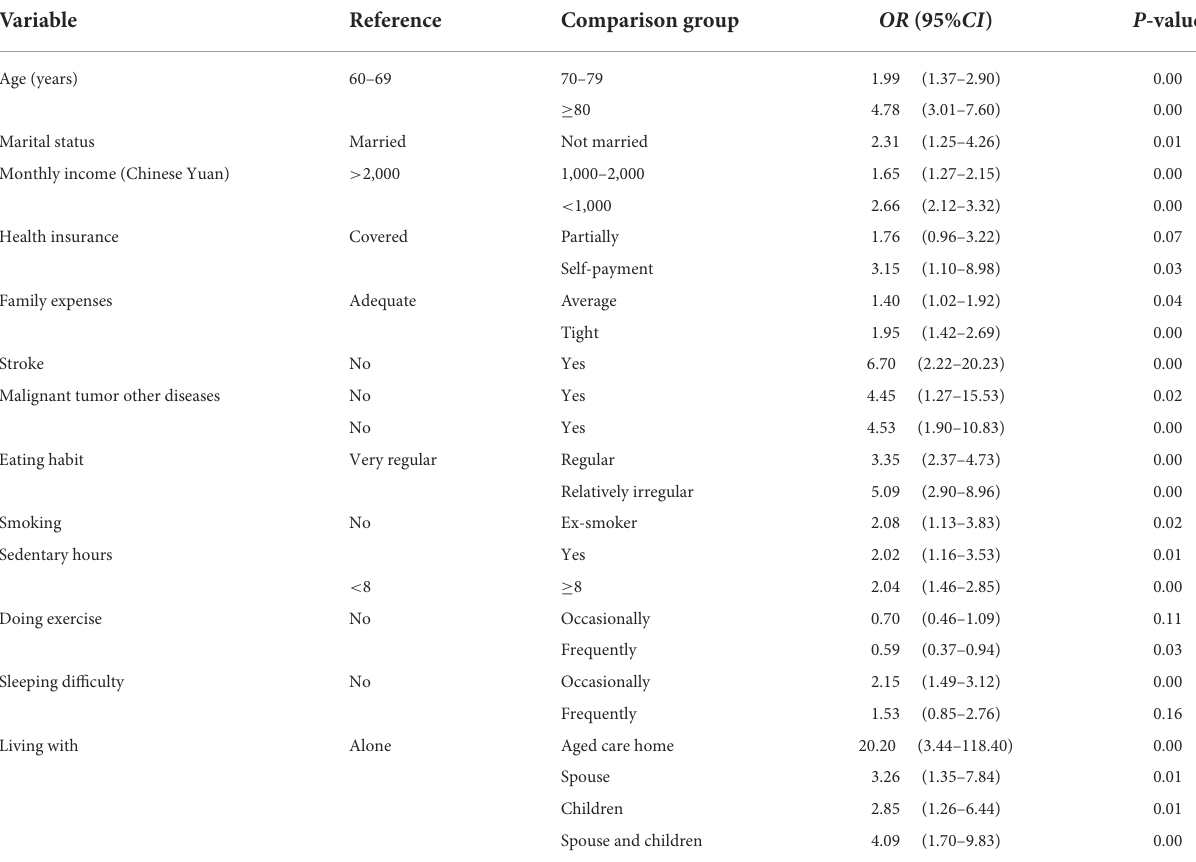
TABLE 6 Identification of factors affecting activities of daily living (ADL) limitation in older people with type 2 diabetes in